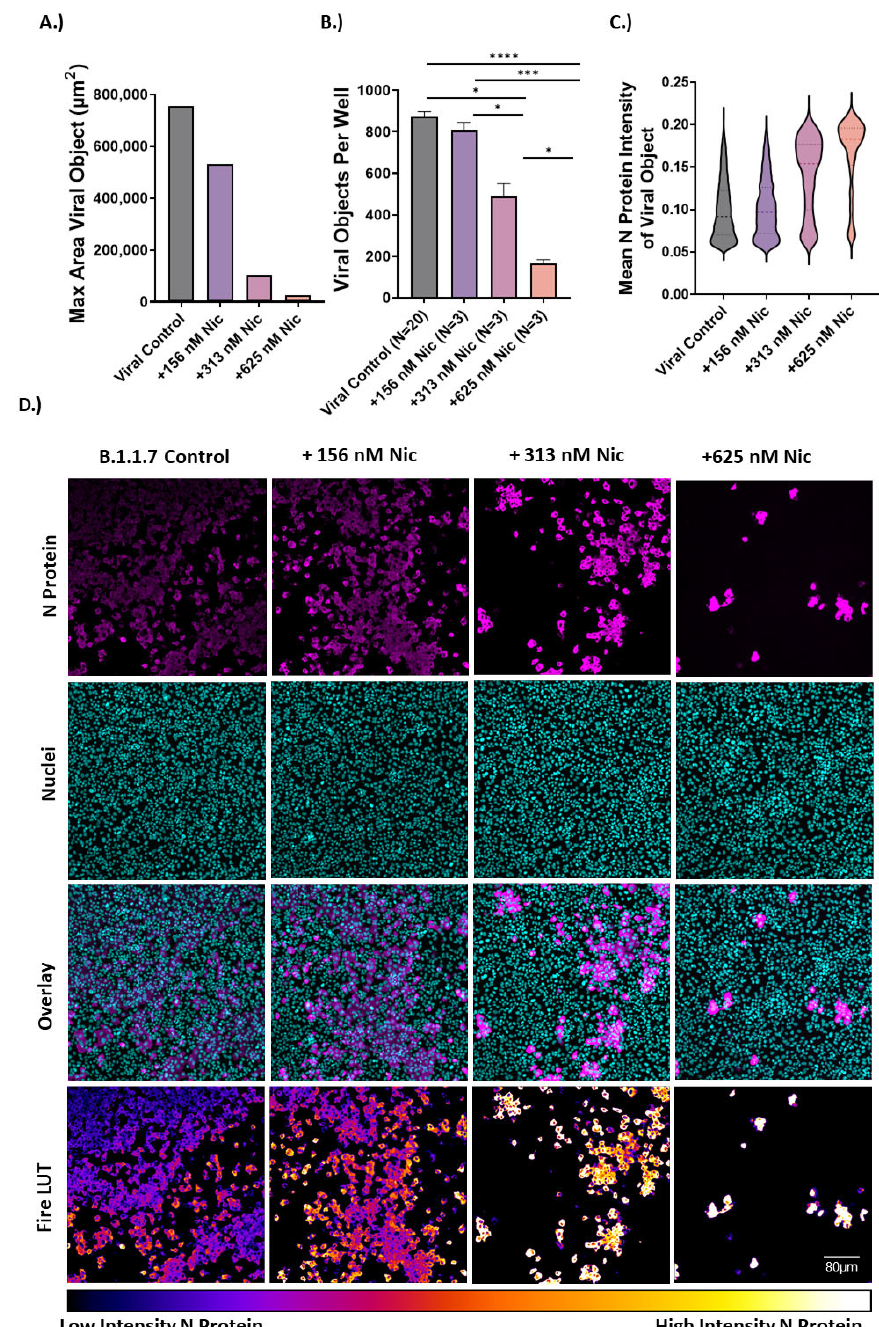
Figure 3. Morphological profiling of B.1.1.7 infection versus niclosamide treatment in VeroE6. Image analysis reveals mechanistic characteristics of niclosamide activity against SARS-CoV-2 infection. ( A ) The maximum area of viral objects decreases with increasing niclosamide concentration. Data are the max area for viral objects in each condition. Viral control: n = 17452, +156 nM niclosamide: n = 2425, +313 nM niclosamide: n = 1470, +625 nM niclosamide: n = 496. ( B ) Viral objects per well decrease with increasing niclosamide concentration. Viral objects include single infected cells and syncytia. Replicate values are indicated on the X axis. ( C ) Mean pixel intensity for viral objects in each condition. Pixel intensity increases with increasing niclosamide concentration. ( D ) Representative images for each condition including N-protein channel, nuclear channel, an overlayed image, and a fire lookup table (LUT) image of the N-protein channel. Images were taken on a CX5 high content microscope at 10 × magnification. * = p < 0.05, *** = p < 0.001, **** = p < 0.0001. (Scale bar = 80 µ M).